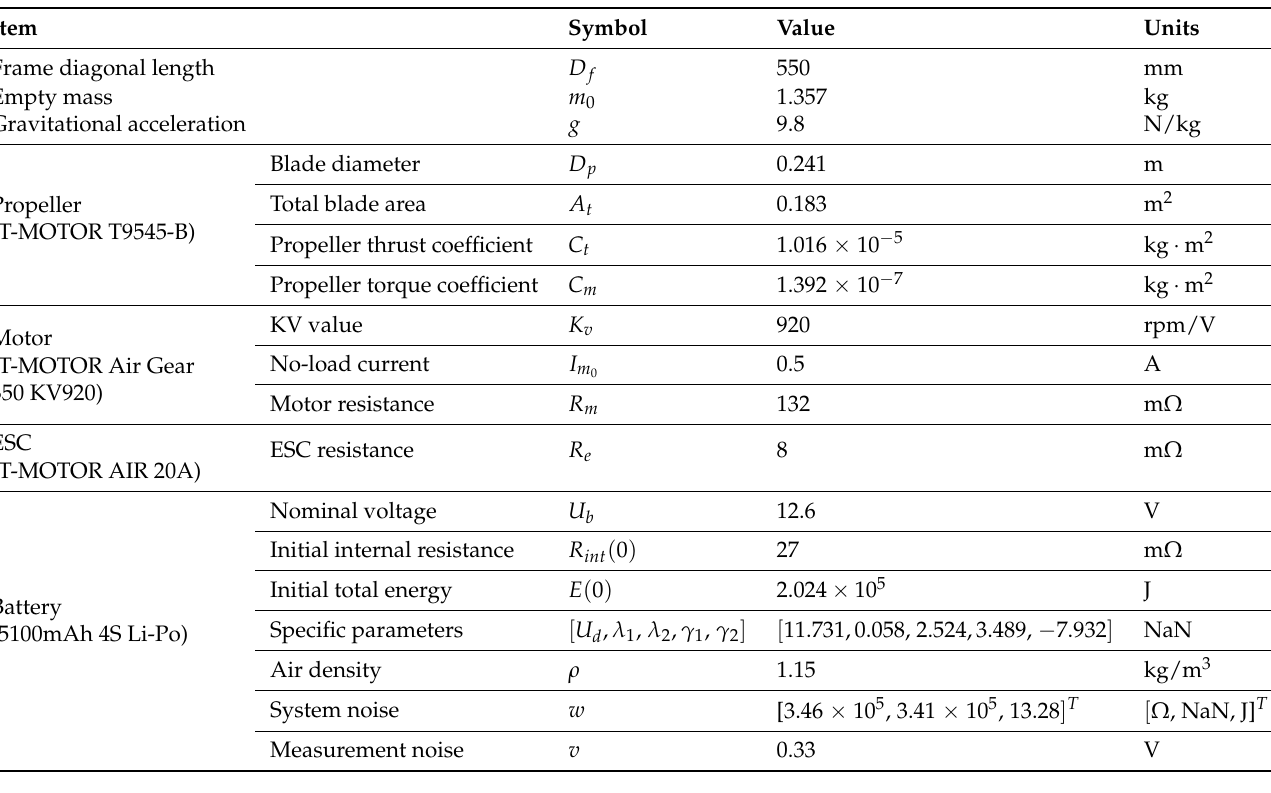
Table 1. Configurations and parameters of the real drone.